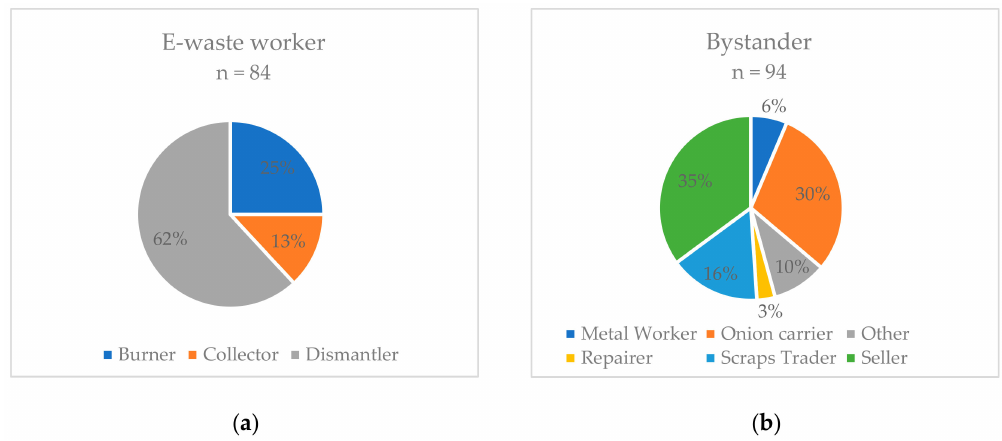
Figure 1. Job tasks of e-waste workers ( a ) and bystanders ( b ) (in percent of subgroups, total n = 178). There were no age di ff erences between the groups (EW mean age = 27 years, range = 18–59 years;